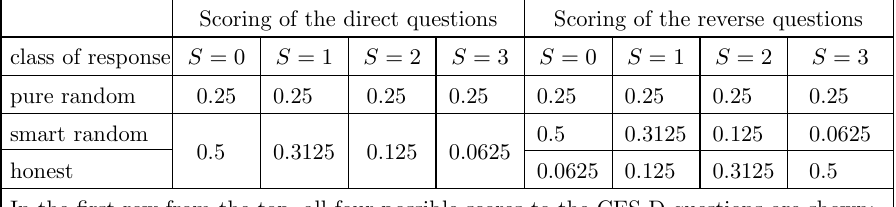
Table 3. The assumed distributions of probability of scoring at the honest and random classes of responses on the direct versus reverse questions of the CES-D scale Scoring of the direct questions Scoring of the reverse